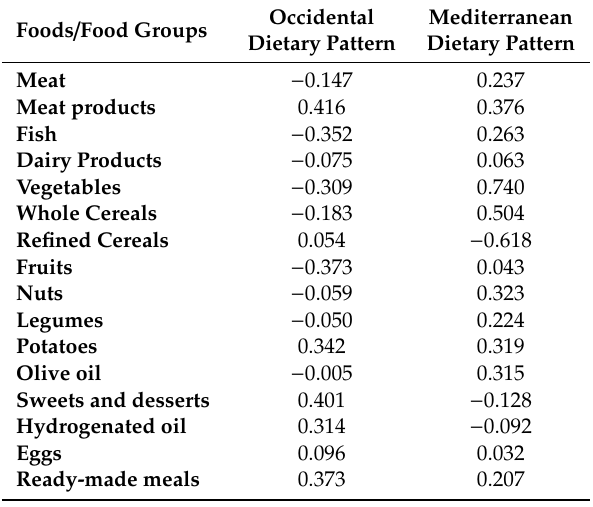
Table 2. Factor loadings for two main dietary patterns derived from a principal component analysis.